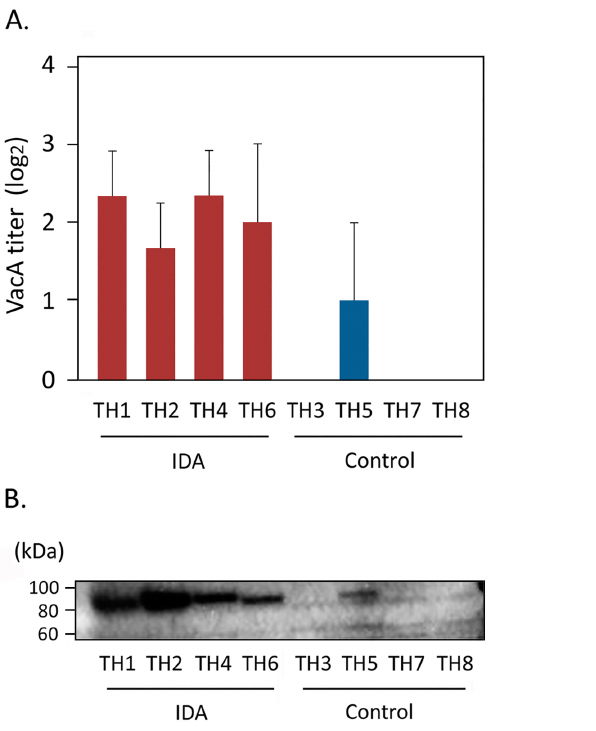
Fig 4. VacA activity in IDA and control strains. Panel A: H . pylori cytotoxic activity. Filtrate obtained from 72-hourcultures of each H . pylori strain was serially diluted and added to AGS cell cultures. After 24-hour incubation, the final dilutionwith visiblevacuoleswas determinedmicroscopically and reciprocalnumber of the dilutionused for calculation. Panel B: Immunoblotanalysisof culture filtrate of the eight H . pylori strains.